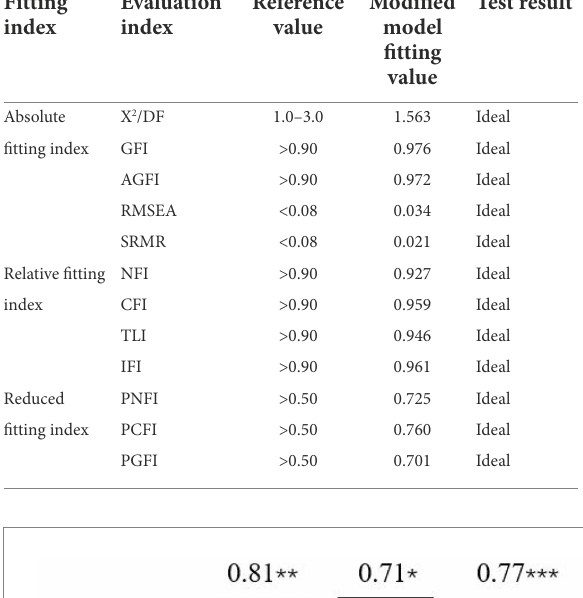
TABLE 5 Fitting results of model fitness.